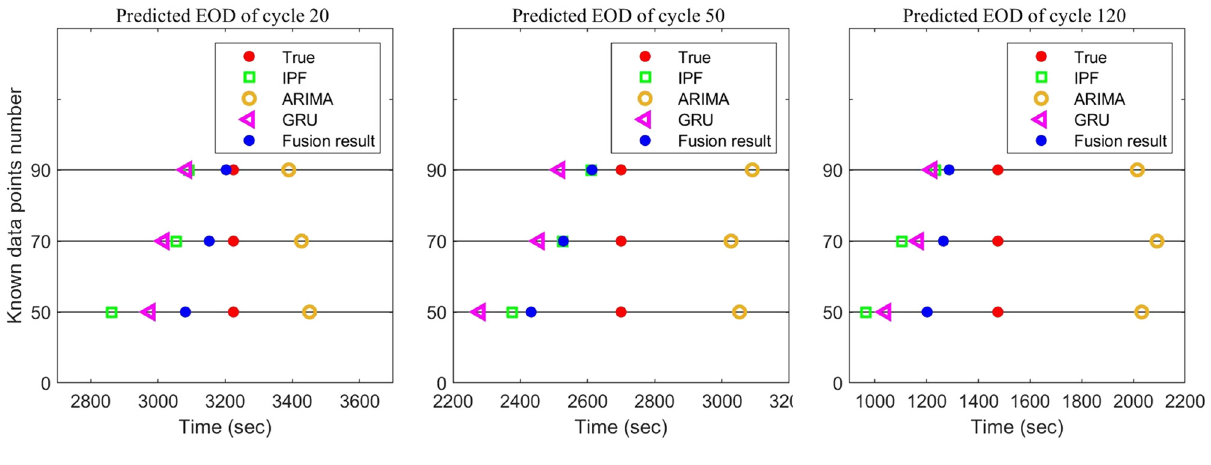
Figure 6: The mean of each prediction result.